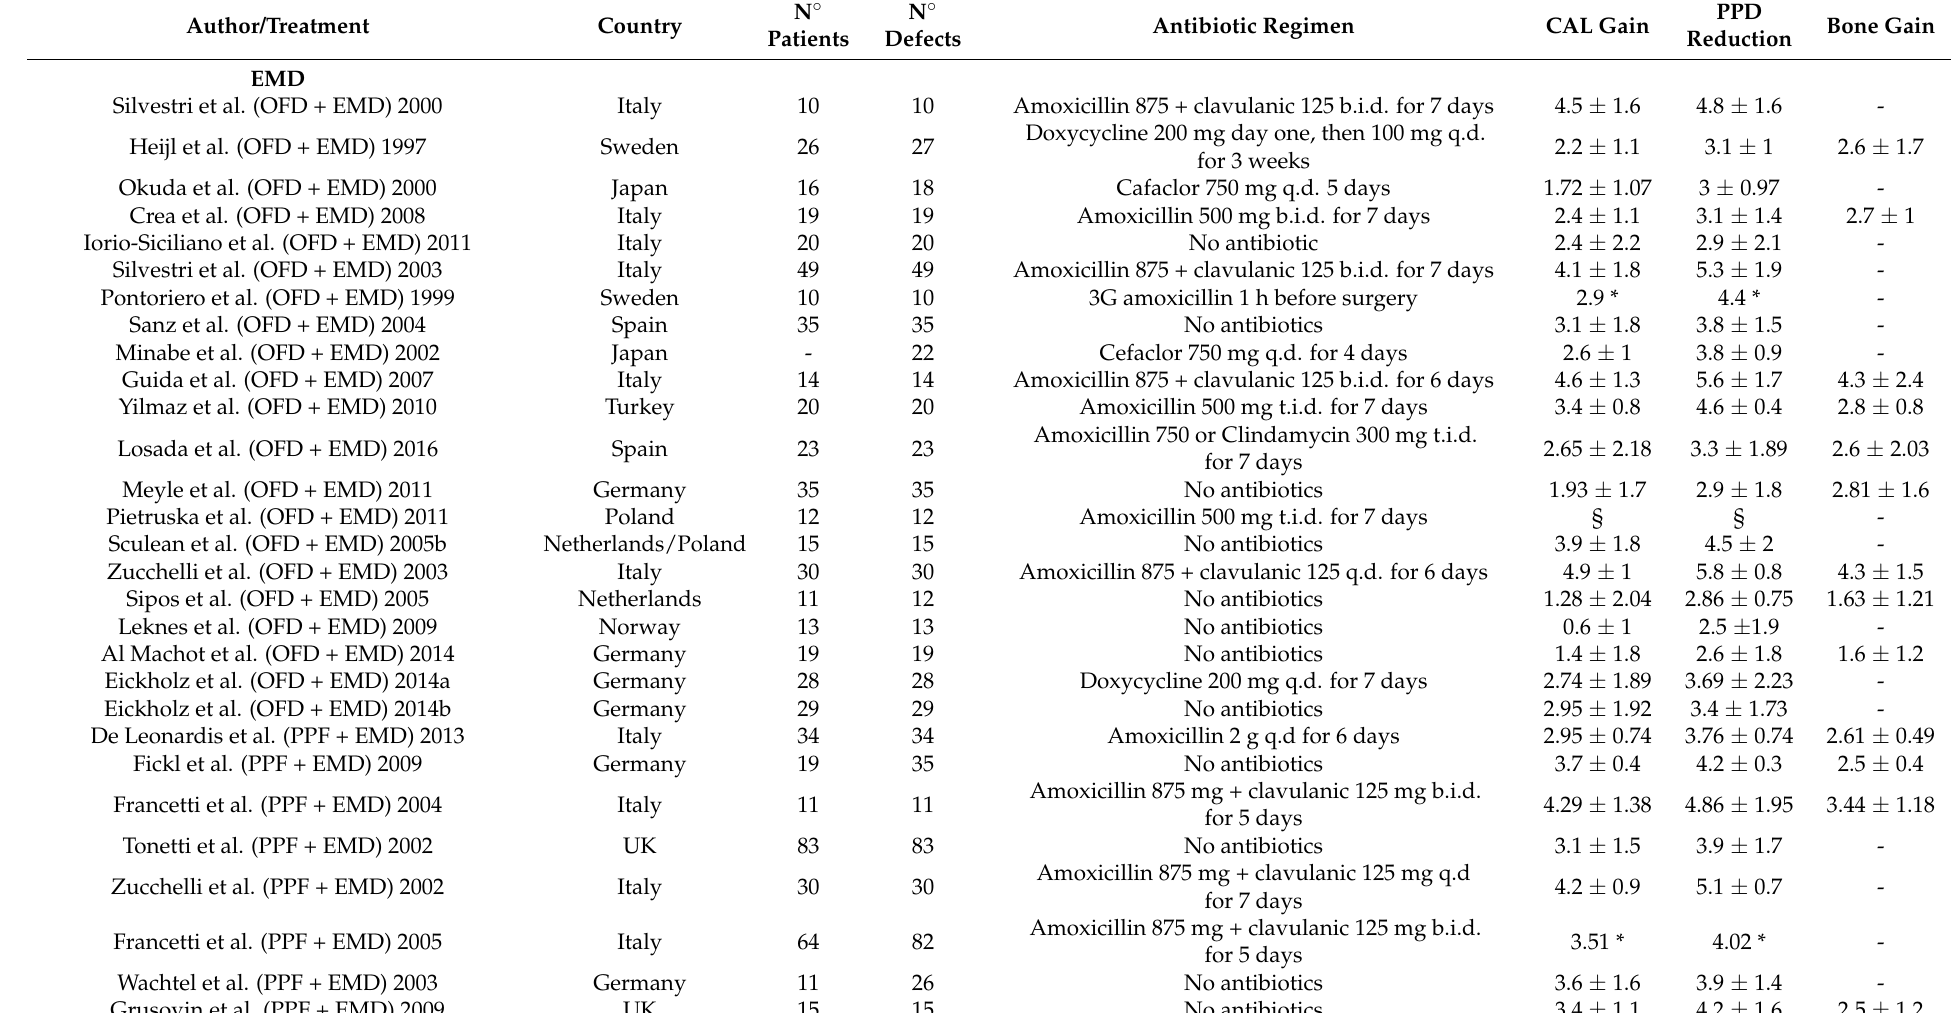
Table 1. Characteristics of the treatment arms from included studies treating intra-bony defects